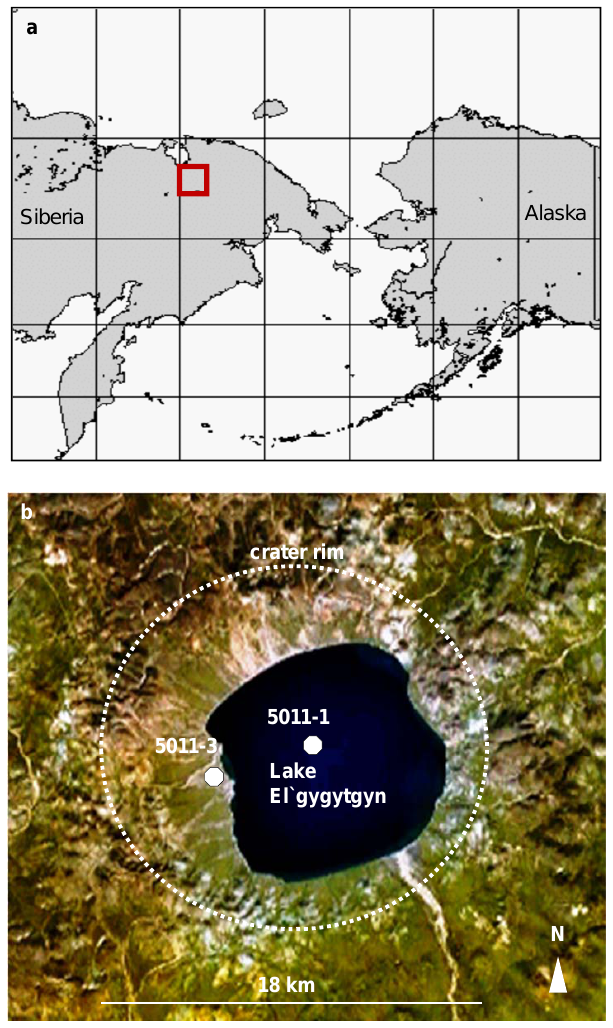
Fig. 1. (a) Geographic position of the El’gygytgyn Crater in NE Russia (red box). (b) A Landsat image showing the crater (dotted line) and the drill sites 5011-1 and 5011-3.